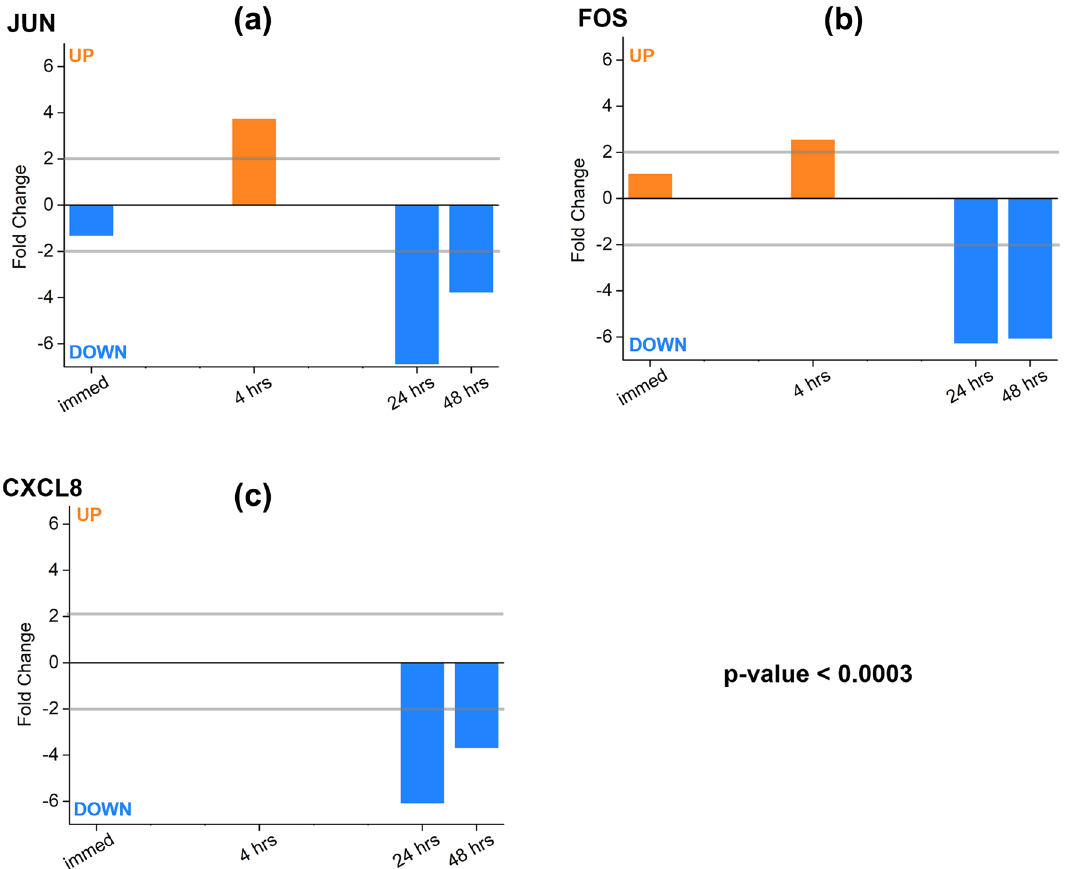
Figure 5. Modification of expression in the ( a ) JUN , ( b ) FOS , and ( c ) CXCL8 genes after THz demethylation in SK-MEL-3 melanoma cell pellets. After 24 h of THz exposure, downregulation with a fold-change over four occurred in these genes ( p -value <